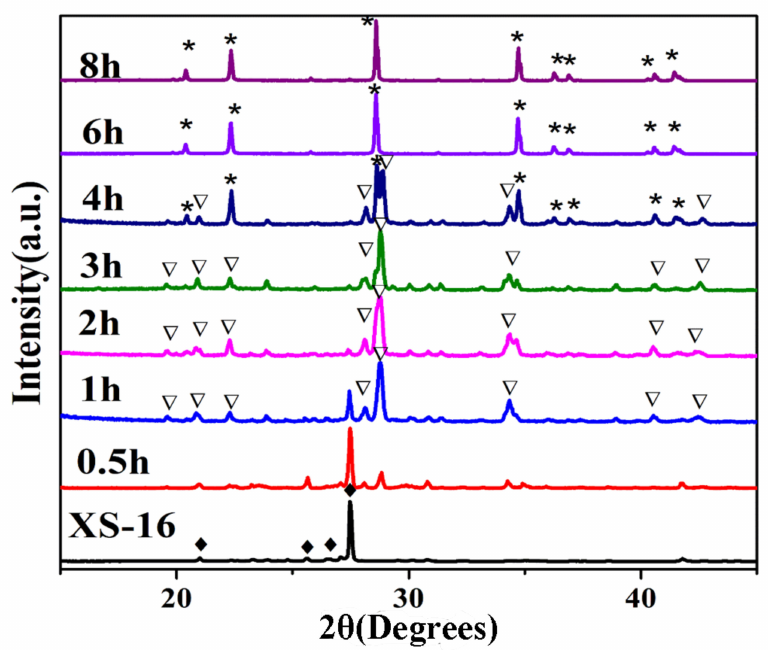
Figure 1. The XRD patterns of K-feldspar and precipitation samples obtained after the hydrothermal treatment of K-feldspar for 0.5 h, 1, 2, 3, 4, 6 and 8 h. (cid:7) —microcline, ∇ —MEK, ∗